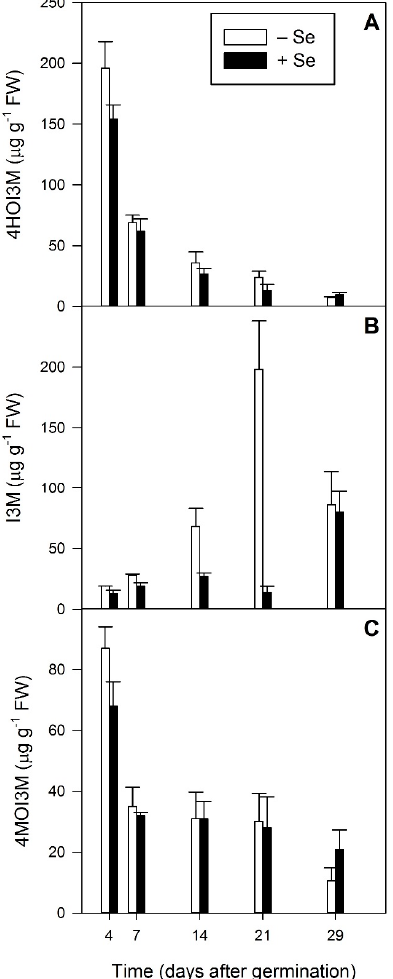
Figure 7. Indole glucosinolates detected using LC-MS analysis of five developmental stages (4, 7, 14, 21 and 29 days after germination) of Raphanus sativus plants grown hydroponically in the absence (white bars) and presence (black bars) of 40 µM sodium selenate. Each bar represents the mean value of three biological replicates, n = 3. Error bars represent the standard error of the mean. ( A ) 4HOI3M: 4-hydroxyindol-3-ylmethyl glucosinolate, ( B ) I3M: indol-3-ylmethyl glucosinolate, 4MOI3M: ( C ) 4- methoxyindol-3-ylmethyl glucosinolate.